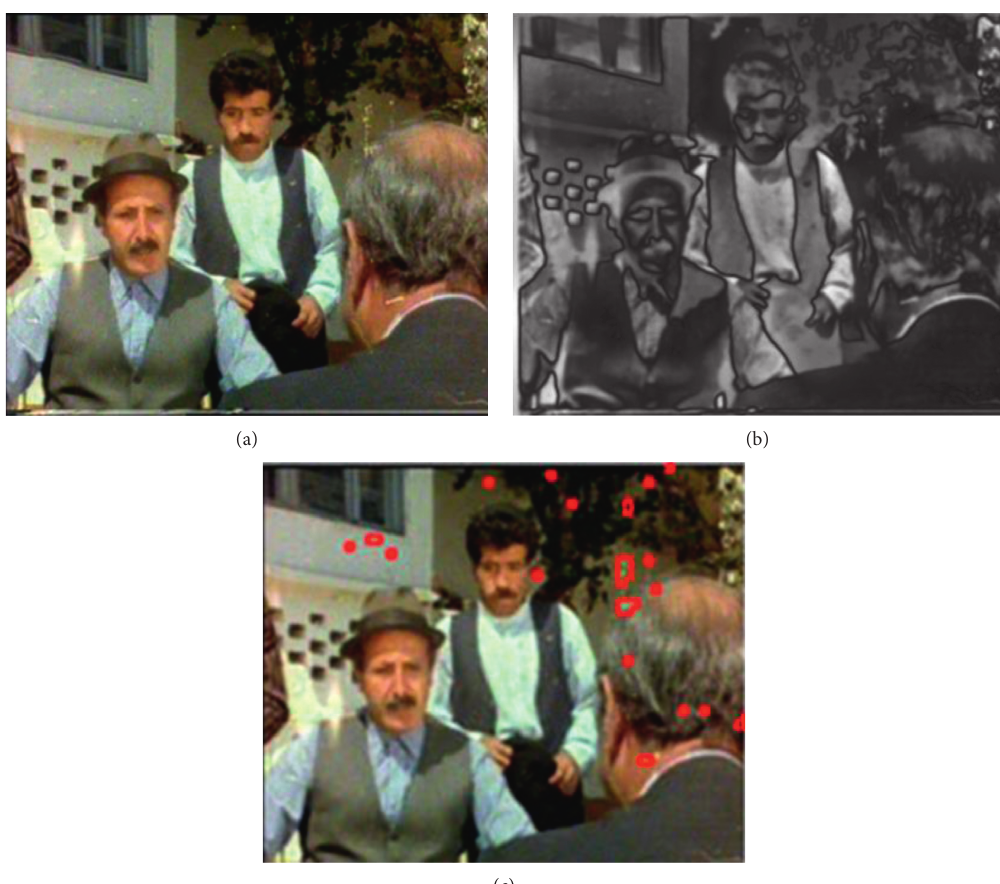
Figure 8: Blotch detection results in the regions that are not exactly obvious: (a) the current frame, (b) the corresponding saliency map, and (c) detected blotches marked red in